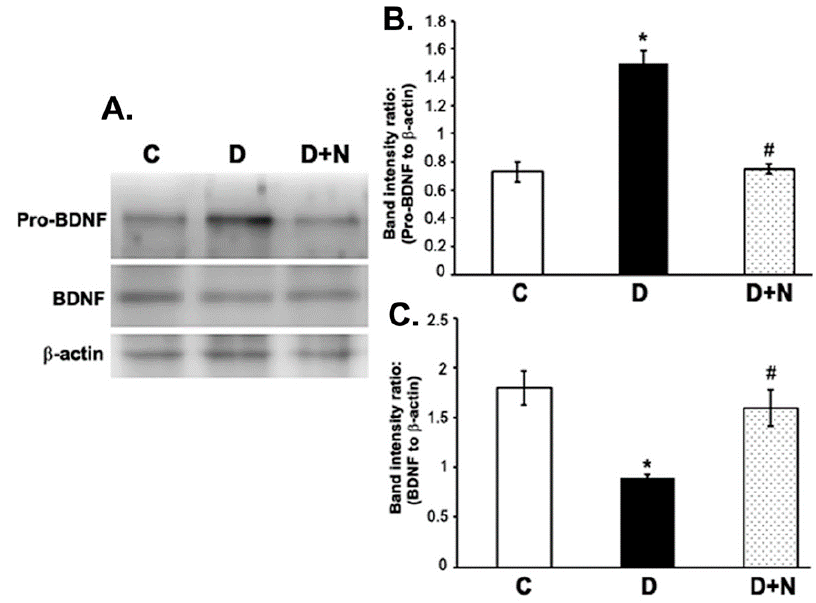
Figure 3. Western blot analysis of the expression of pro-BDNF and BDNF in retinas from control, diabetic, and naringenin-treated diabetic rats. The intensities of the bands were quantified by densitometry. ( A ) Representative immunoblots of pro-BDNF, BDNF and β -actin bands; ( B , C ) Data presented as ratios of those protein bands to β -actin. Values are means ± SEM; n = 6/group. * p < 0.05, significantly different from their controls; # p < 0.05, significantly different from diabetic. BDNF (brain derived neurotrophic factor), pro-BDNF (precursor of brain derived neurotrophic factor). C represents control, D as diabetic, and D + N as diabetic rats treated with